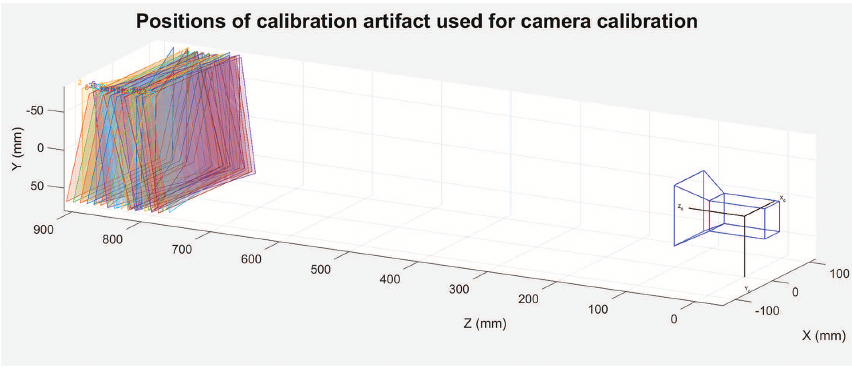
Figure 13. Positions of the calibration artifact used for camera calibration. A real camera model was used, and the calibration method is described in Ref. [7].